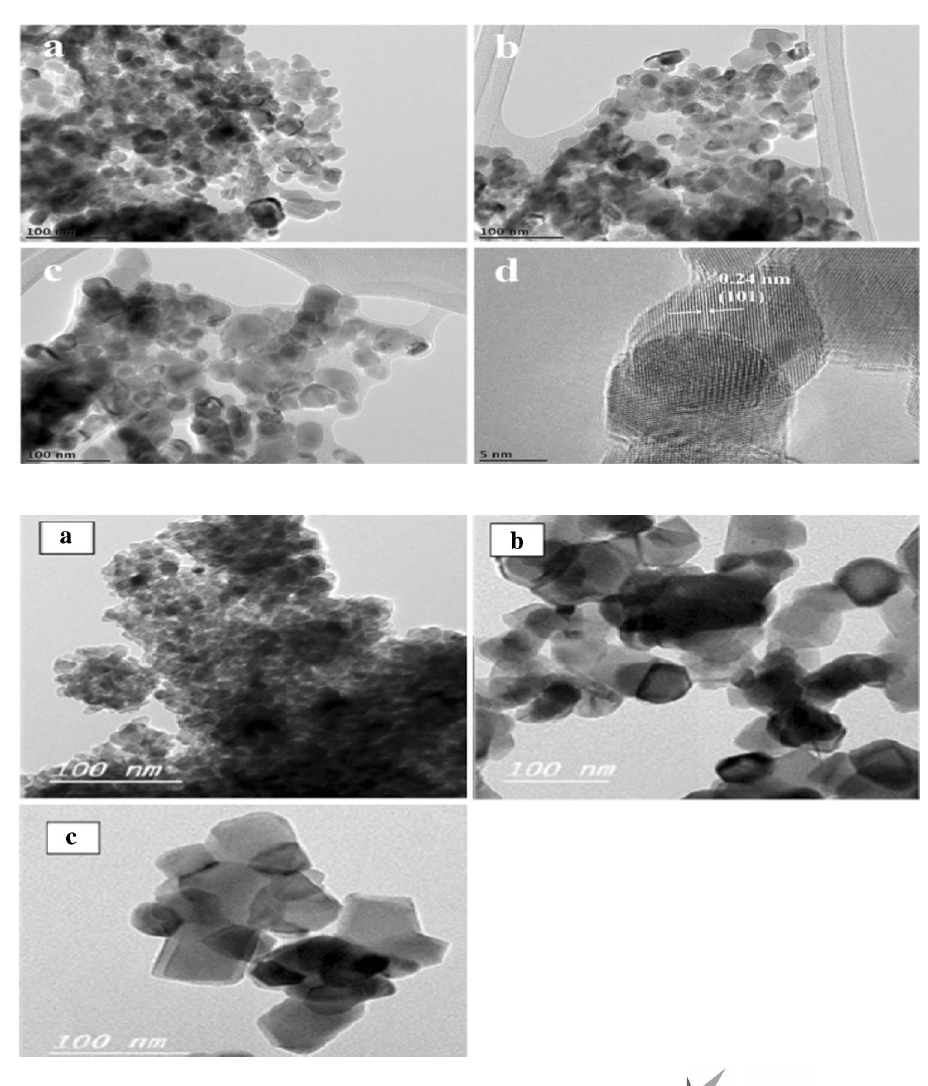
Fig. 9 HRTEM images of ZnO nanoparticles at a 500 °C, b 600 °C and c 700 °C as well as d high magnification of the ZnO (Golsheikh et al. 2017)